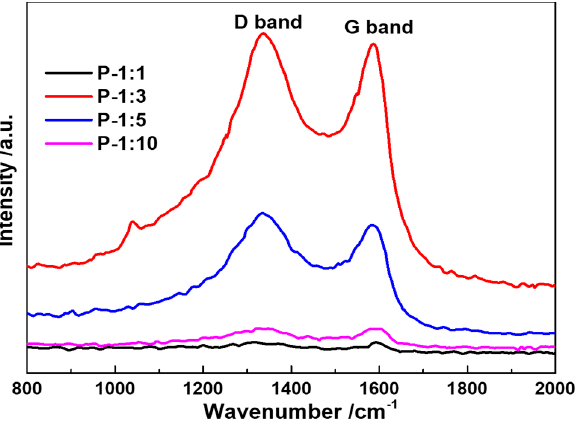
Figure 4. Raman spectra of Ni-Co-P samples with different ratio from 1:1, 1:3, 1:5, and 1:10.